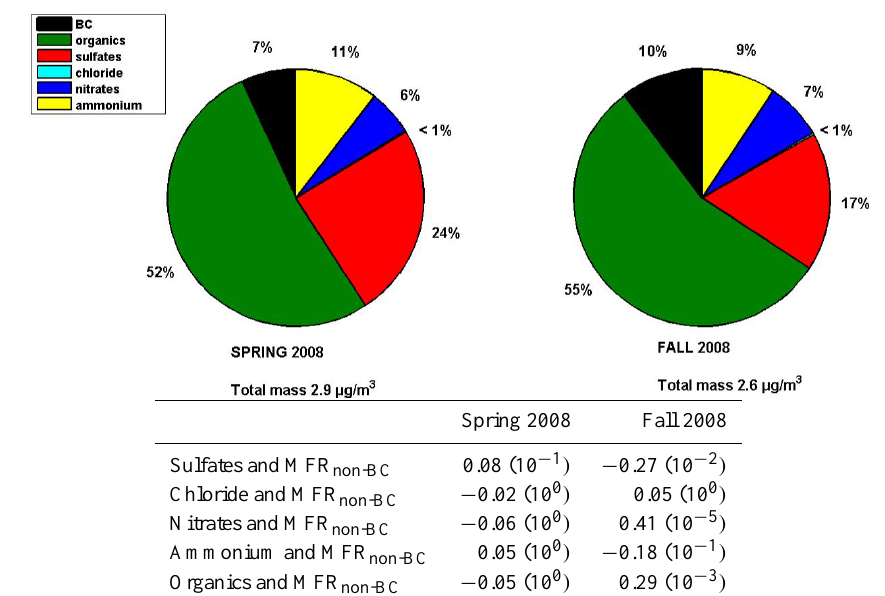
Fig. 9. Median aerosol chemical composition during AMS measurement campaigns in spring and fall 2008 is illustrated in the upper panel. BC mass measured with an aethalometer is included in the total aerosol mass and the median total mass concentrations of particles are provided. The correlation ( r and p-value in parenthesis) between MFR non-BC at 280 ◦ C and mass fractions of AMS-compounds is presented in the lower panel.